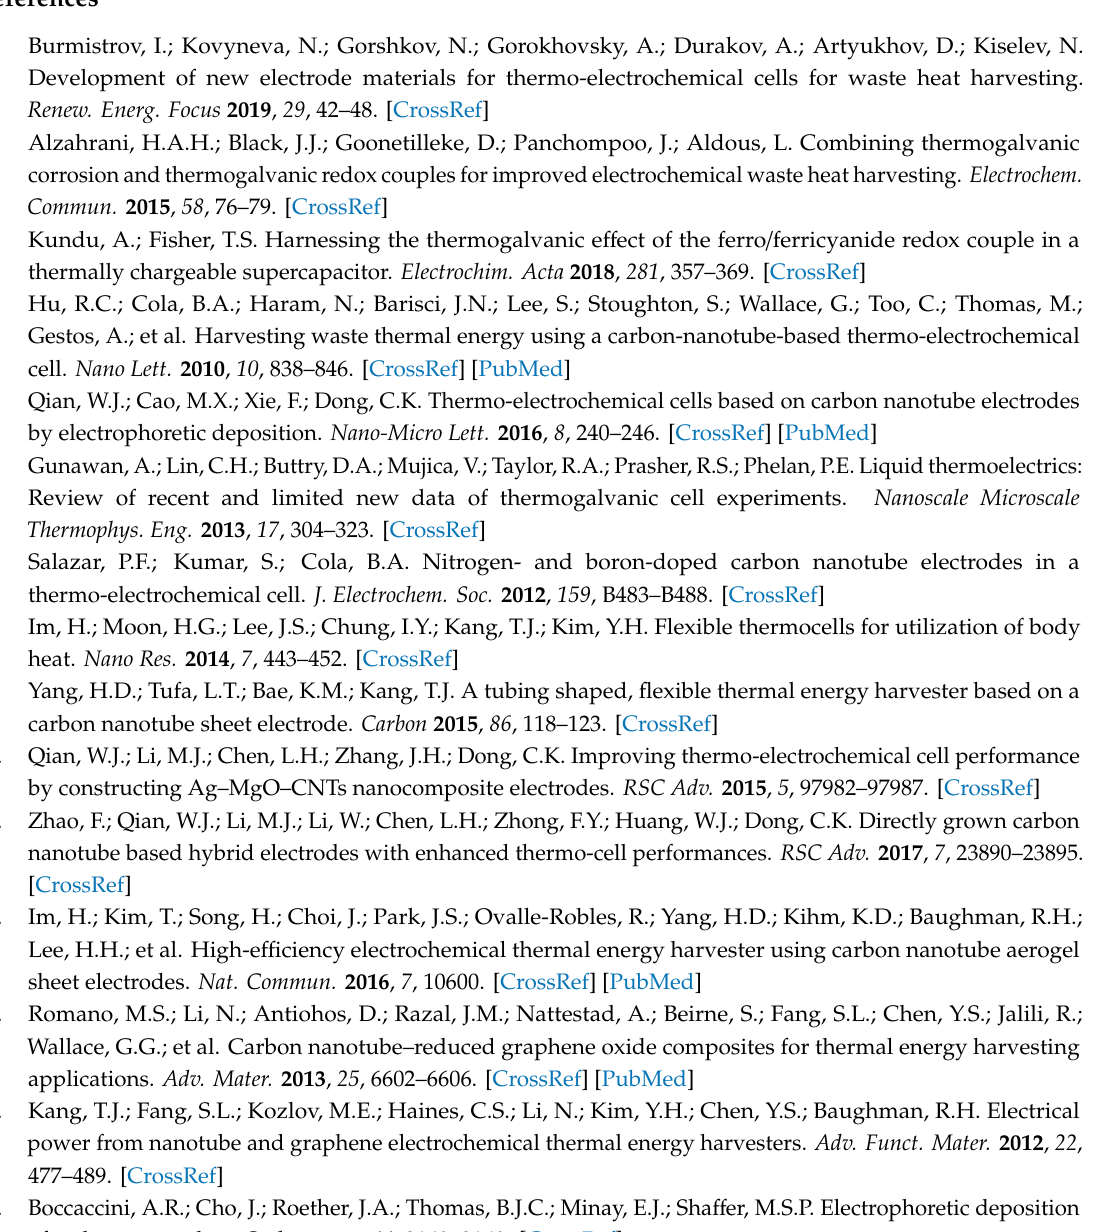
Table S1: Comparison on TEC performances of di ff erent